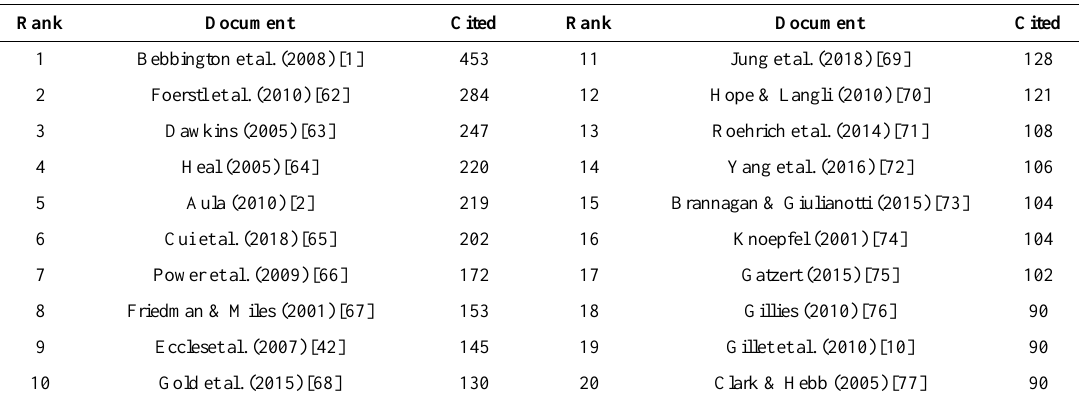
Table 1. Top cited published reputation risk